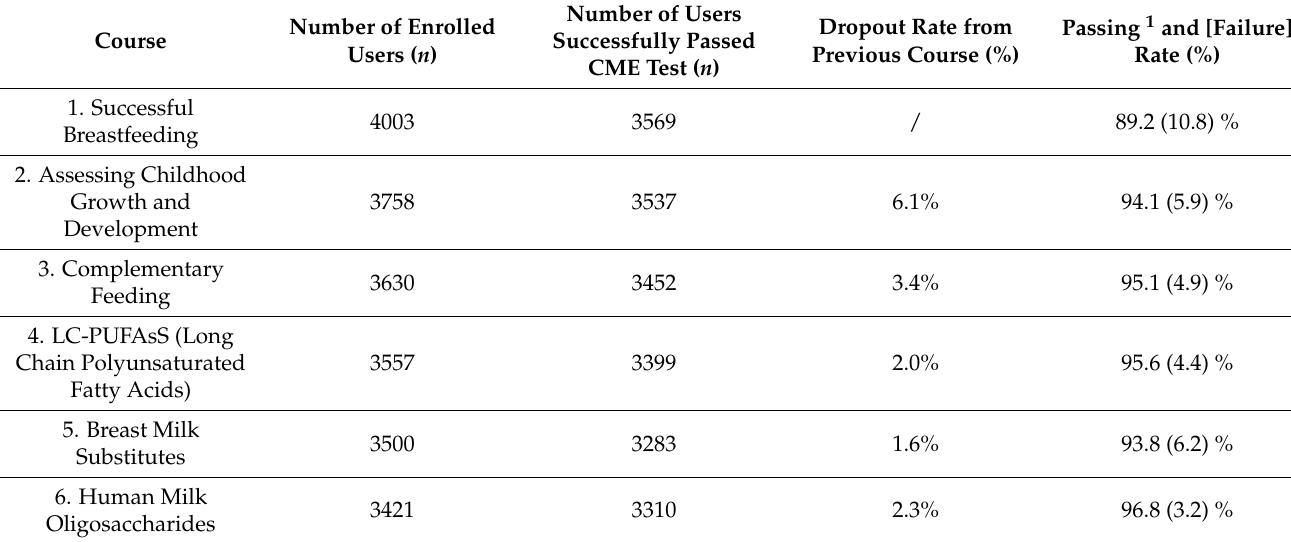
Table 2. Completion and Continuing Medical Education (CME) test passing rates/dropout rates per